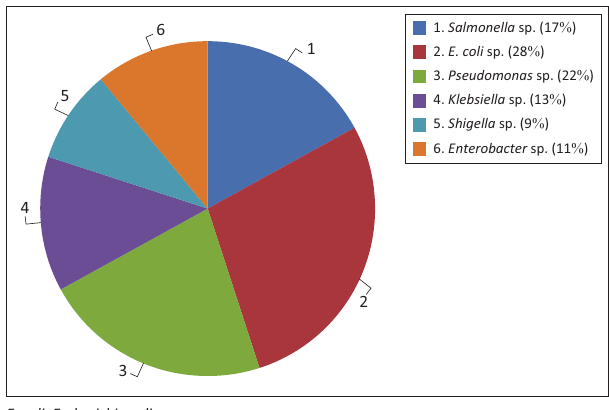
FIGURE 1: Frequency of occurrence of isolated bacterial species in the abattoir wastewater.